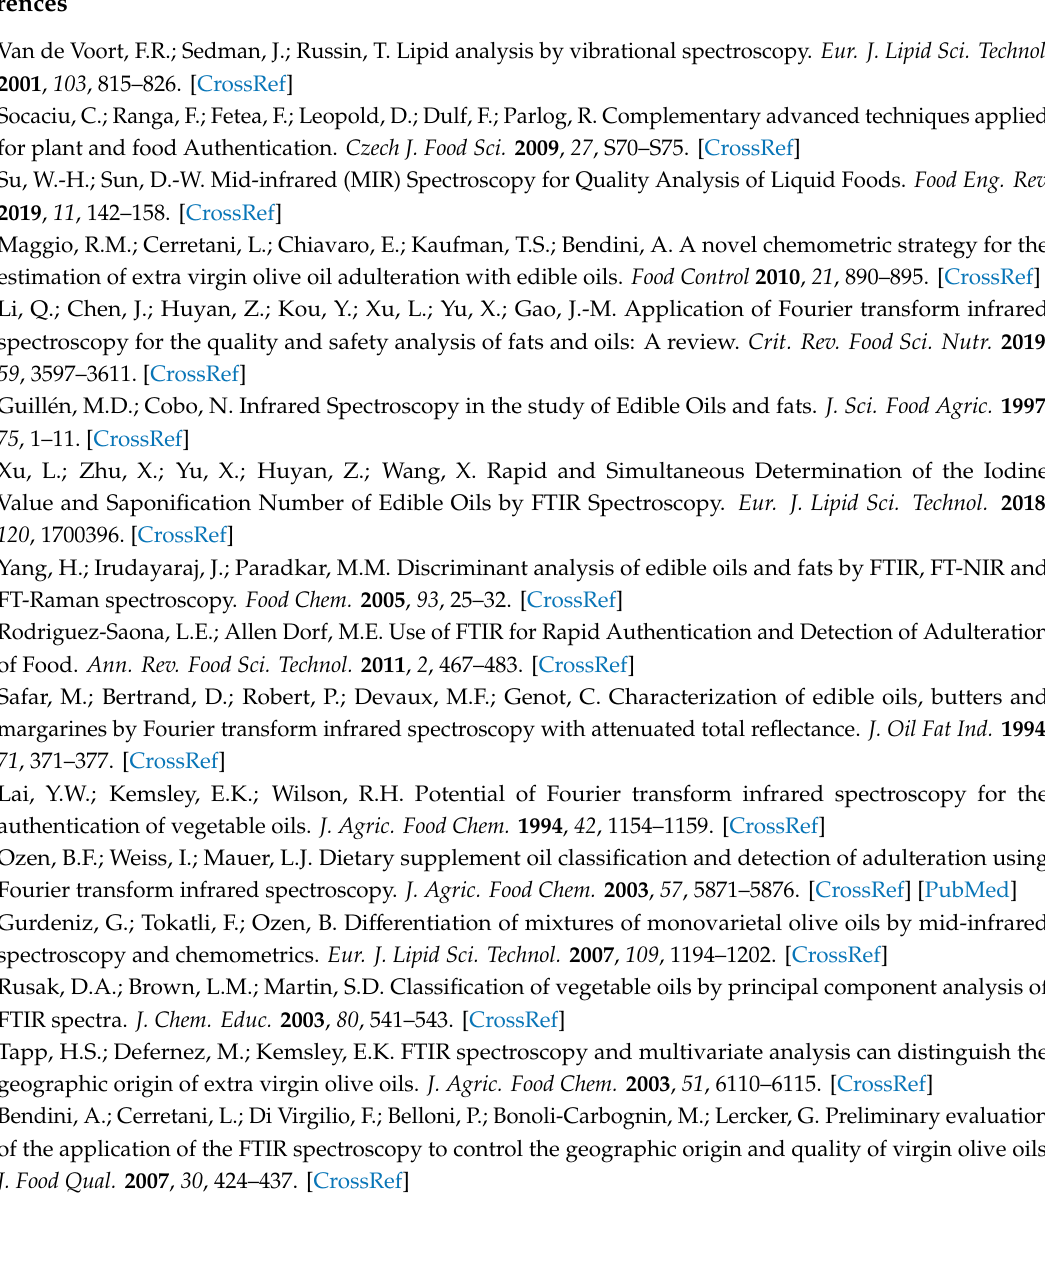
s1, Figure S1: ATR-FTIR-MIR spectra of the eight authentic group oils considering the fingerprint region (1800–650 cm − 1 ). For abbreviations see Table